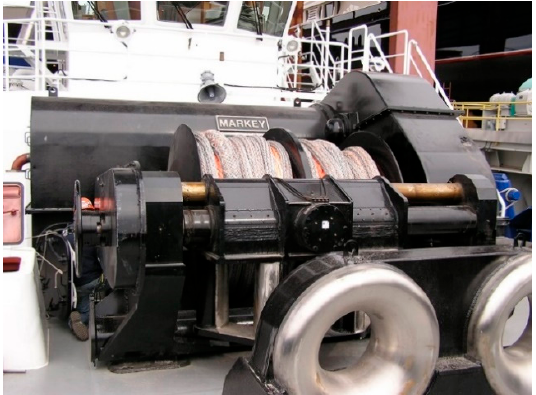
Figure 11. Asymmetric Render/Recover ® Hawser Electric Winch model DESDF-48-200 from Markey Machinery.